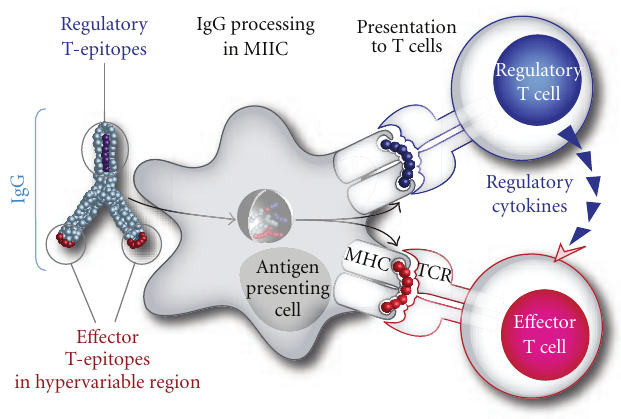
Figure 2: Proposed role of Tregitopes in IgG. Adapted with permission from de Groot et al. [18]. Antibody-derived Treg epitope (dark blue) activated regulatory T cells (Treg), which leads to suppression of e ff ector T cells (Te ff ) that recognize e ff ector epitope (red), like those of IgG hypervariable regions to which central tolerance does not